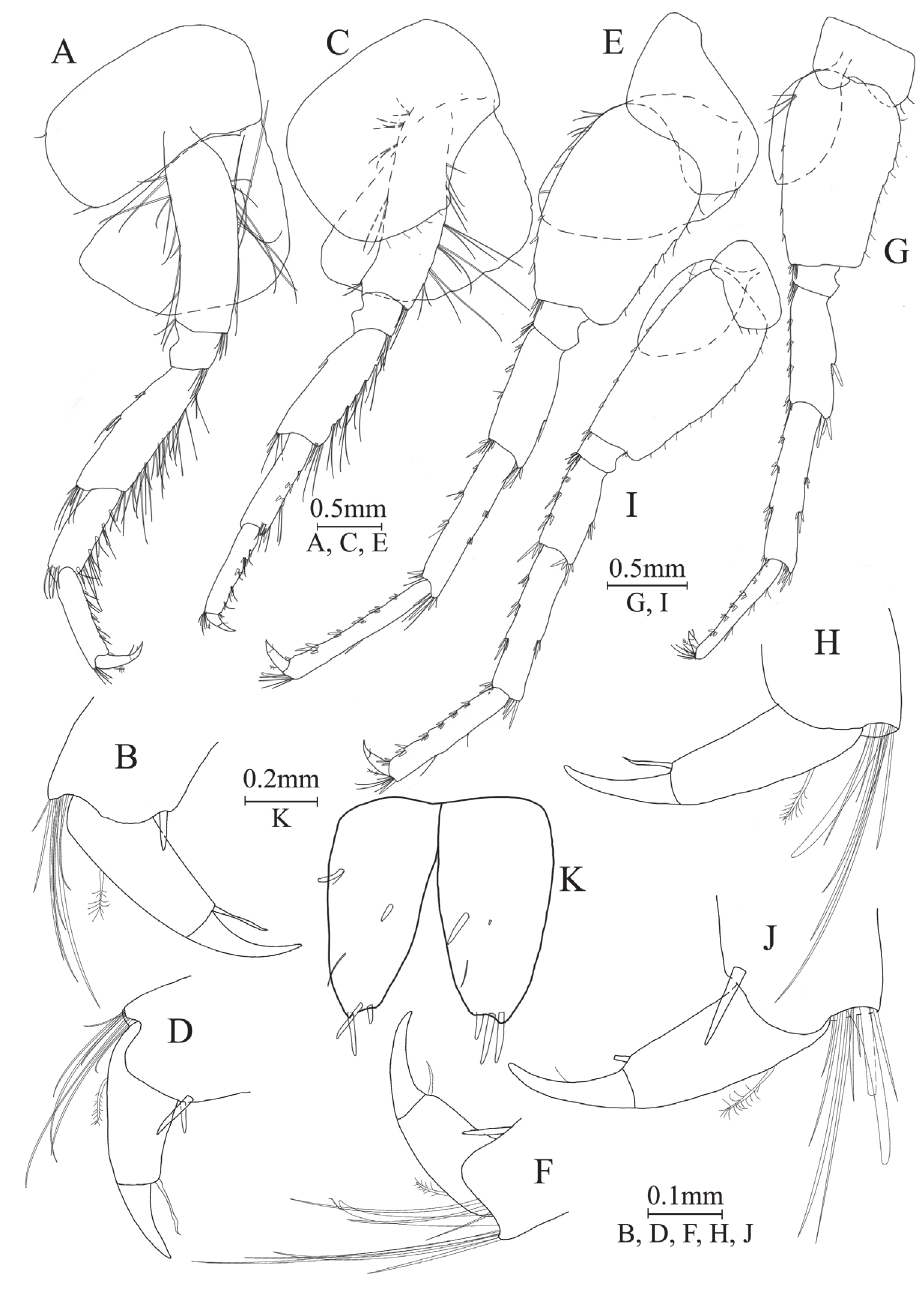
Figure 7. Gammarus zhouqiongi sp. nov., male holotype A pereopod III B dactylus of pereopod III C pereopod IV D dactylus of pereopod IV E pereopod V F dactylus of pereopod V G pereopod VI H dactylus of pereopod VI I pereopod VII J dactylus of pereopod VII K